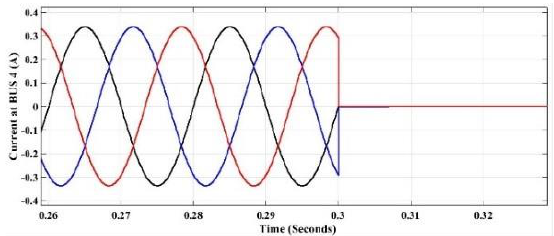
Fig.16 Breaker trips at